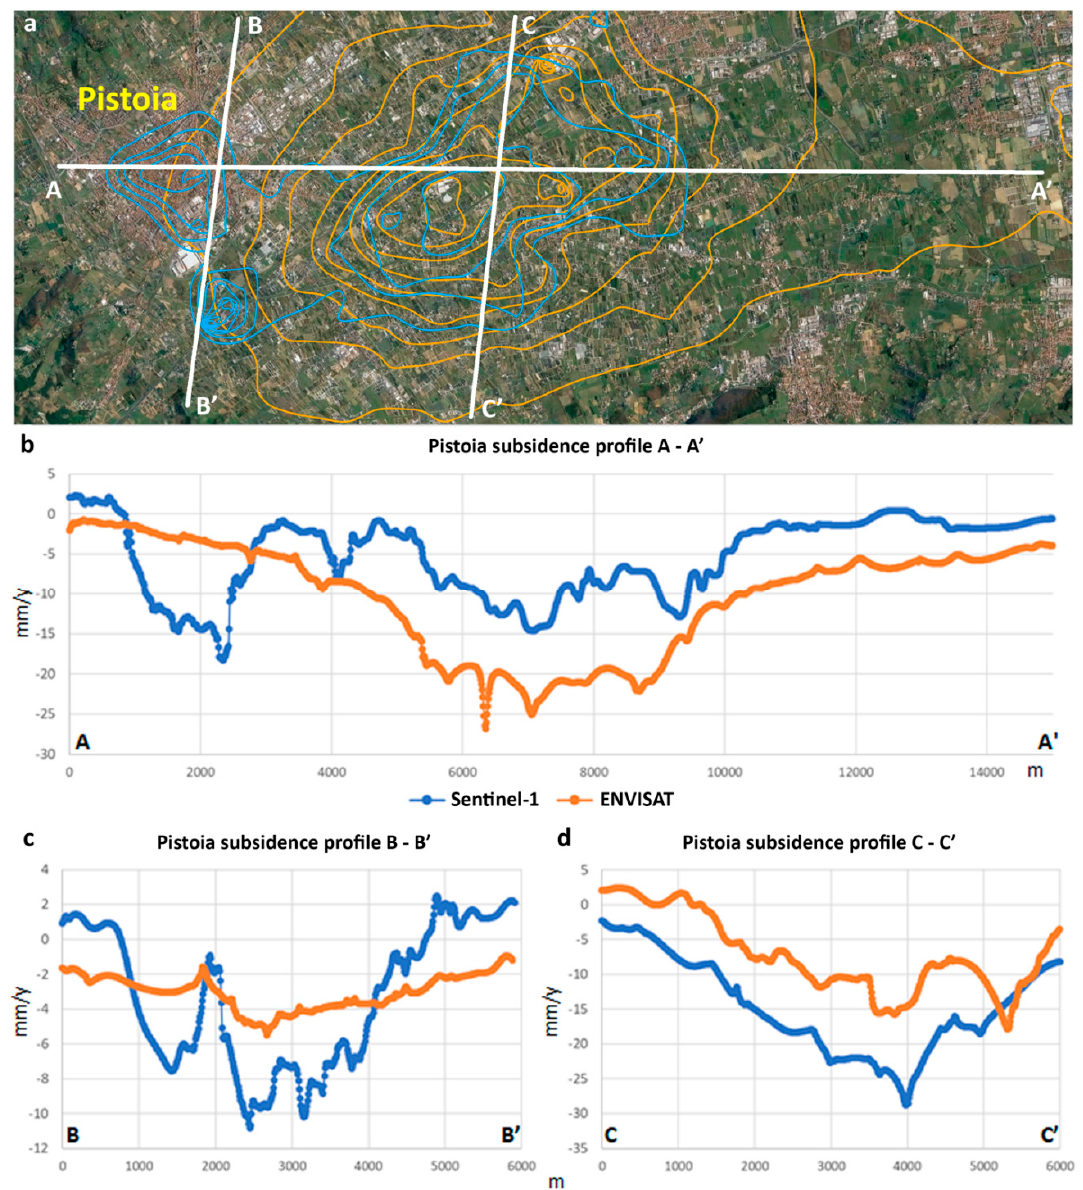
Figure 10. Subsidence trace ( a ) and cross section of Pistoia. One N-S profile (A-A’, ( b )) and two E-W profiles (B-B’, ( c ), and C-C’, ( d )). ENVISAT data acquired from 2003 to 2010, Sentinel-1 data acquired from 2014 to 2017.